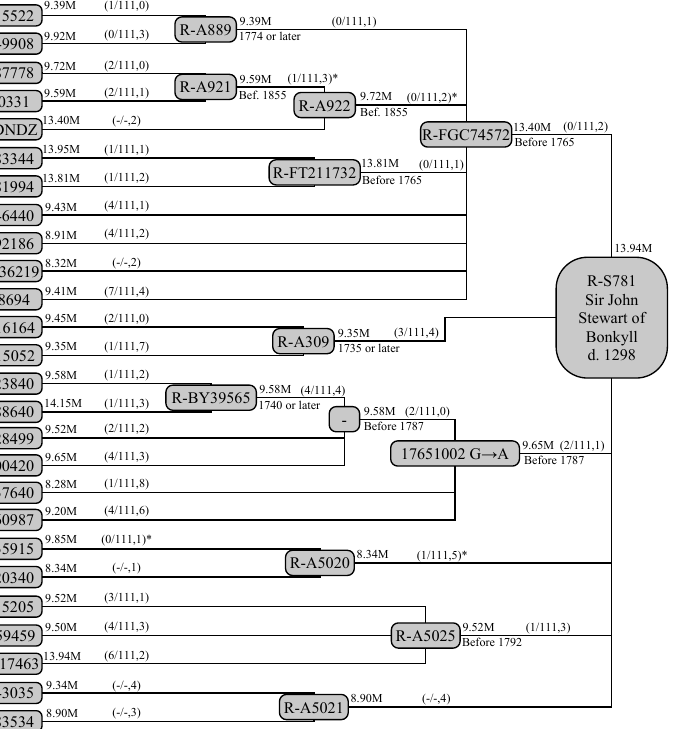
Figure 4. A schematic representation of the example given in Section 3.4. Individual testers and the haplogroups they form are shown as the interconnected grey boxes. Participants are listed using the identifier assigned by their testing company. Measured or estimated coverage, in millions of base pairs, is shown to their upper-right; restrictions known from paper genealogies are shown to their lower-right. Between testers and haplogroups, in brackets, are shown the number of STR mutations that have occurred ( g ), the number of STR markers tested, and the number of SNP mutations that have occurred within the region of testing used for the parent haplogroup (¯ b ). Note that the mutation at GRCh38 position 17651002 is sometimes designated A22007; R-A309 is labelled by Family Tree DNA by the alternative name R-A306. The asterisked genetic distances cannot be uniquely placed in the tree, due to lack of STR results for some testers: these are discarded for this